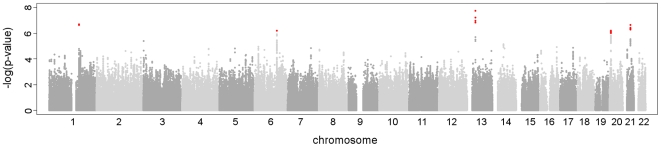
Manhattan plot for QT interval based on GWAS meta-analysis of TwinsUK, BRIGHT, and DCCT/EDIC cohorts.SNPs are ordered along the chromosomes on the x-axis. The −log10 (P) results are plotted for 2,399,142 SNPs of the meta-analysis of TwinsUK, BRIGHT and DCCT/EDIC cohorts for 3,558 individuals. The red dots indicate SNPs with P<10−6.